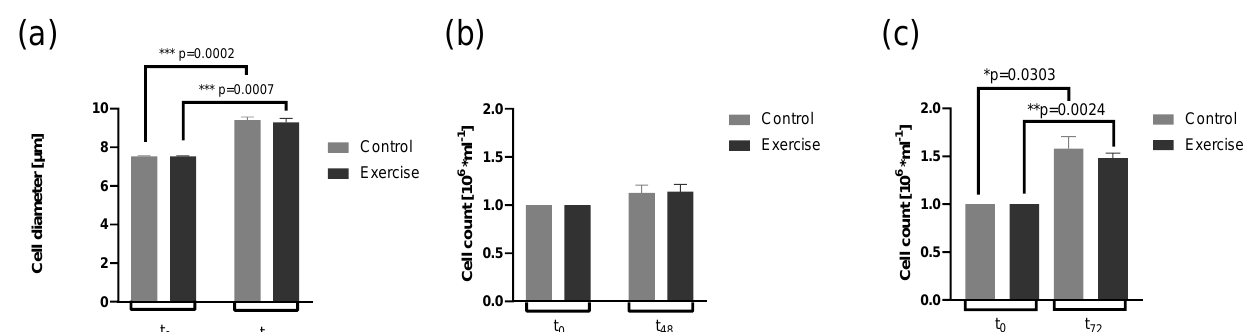
Figure 2. Effects of control and exercise serum on cell parameters. Cell diameter at the beginning (t0) and after 48 h cell culture (t48, a , n = 7) from cohort 2, cell count at t0 and t48, ( b , n = 7), and cell count at t0 and 72 h after cell culture from cohort 1 (t72, c , n = 5) are shown with mean and ± SEM. We used one-way ANOVA with Geisser–Greenhouse correction followed by Bonferroni’s post hoc; * p < 0.5, ** p < 0.01, *** p < 0.001). ANOVA: analysis of the variance.